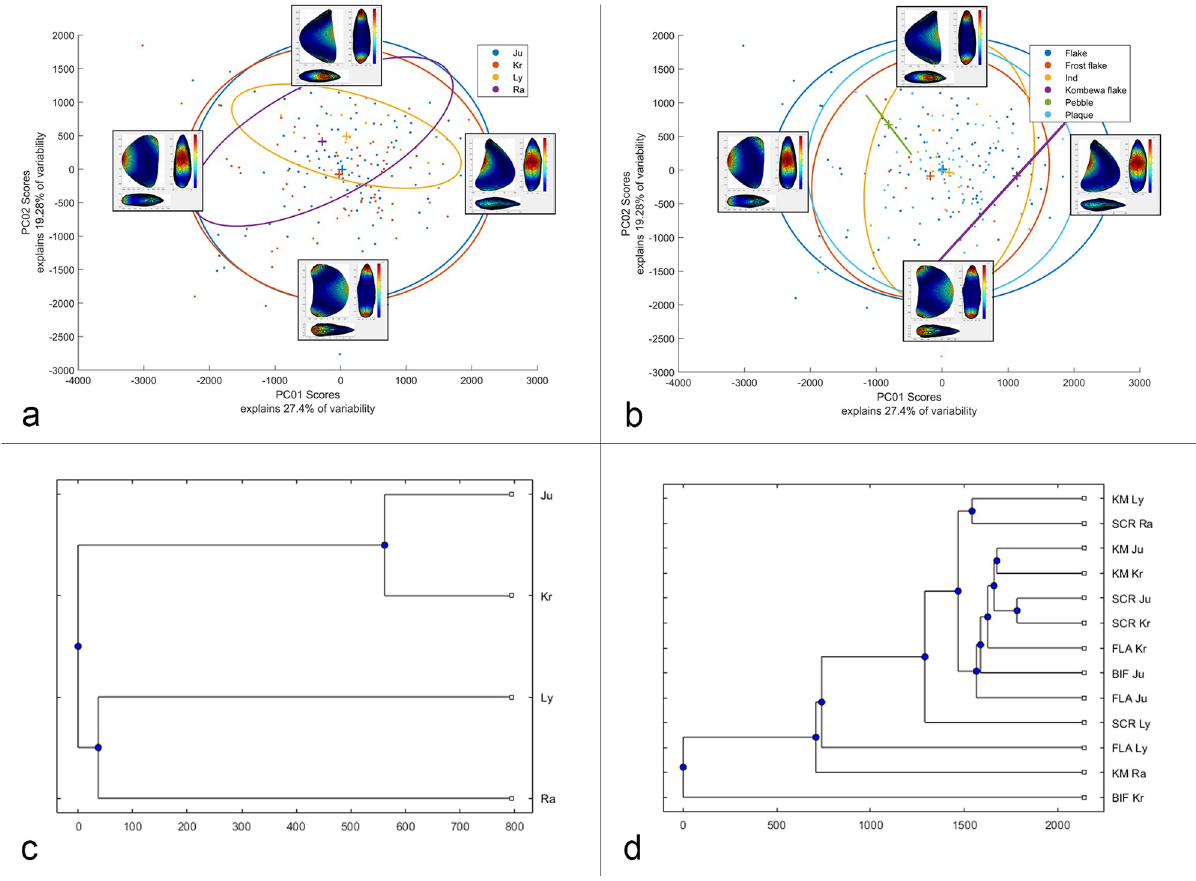
Fig 14. Scatter plot showing the variability of tools for raw material (a) and raw blank type (b), group distance for raw materials (c) and tool types plus raw materials (d); (“KM”: Keilmesser; “SCR”: scrapers; “FLA”: flakes; “BIF”: other bifacial tools; “Ju”: Jurahornstein; “Kr”: Cretaceous chert and quartzite; “Ra”: Radiolarite; “Ly”: Lydite).